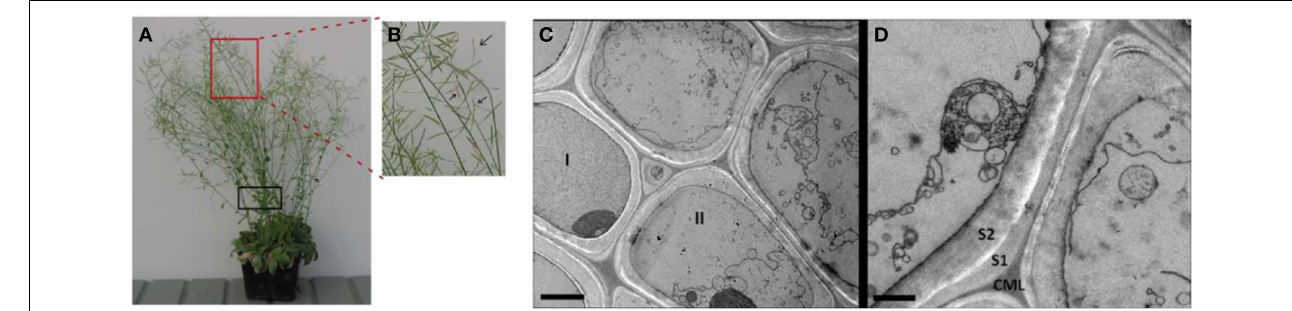
cytoplasm, indicating cell is in pre- or very early stages of senescence. Cell II and the others in the field of view are in later stages of senescence, exhibiting deconstructed membranes and organelles. Scale bar 2 µ m. (D) Membrane and organelle fragments adhere to secondary cell wall surfaces during senescence. Scale bar 1 µ m. CML, compound middle lamella; S1, first layer of secondary cell wall; S2, second layer